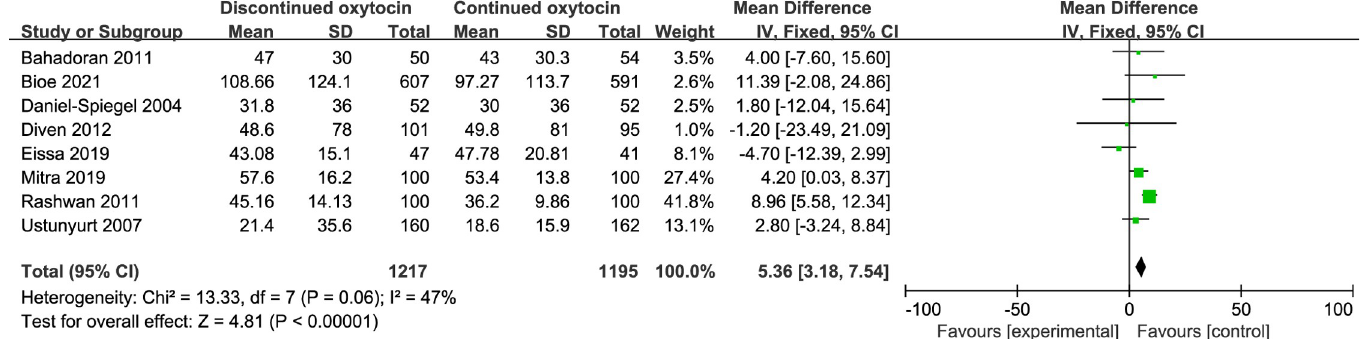
PLOS ONE | https://doi.org/10.1371/journal.pone.0267461 May 2,